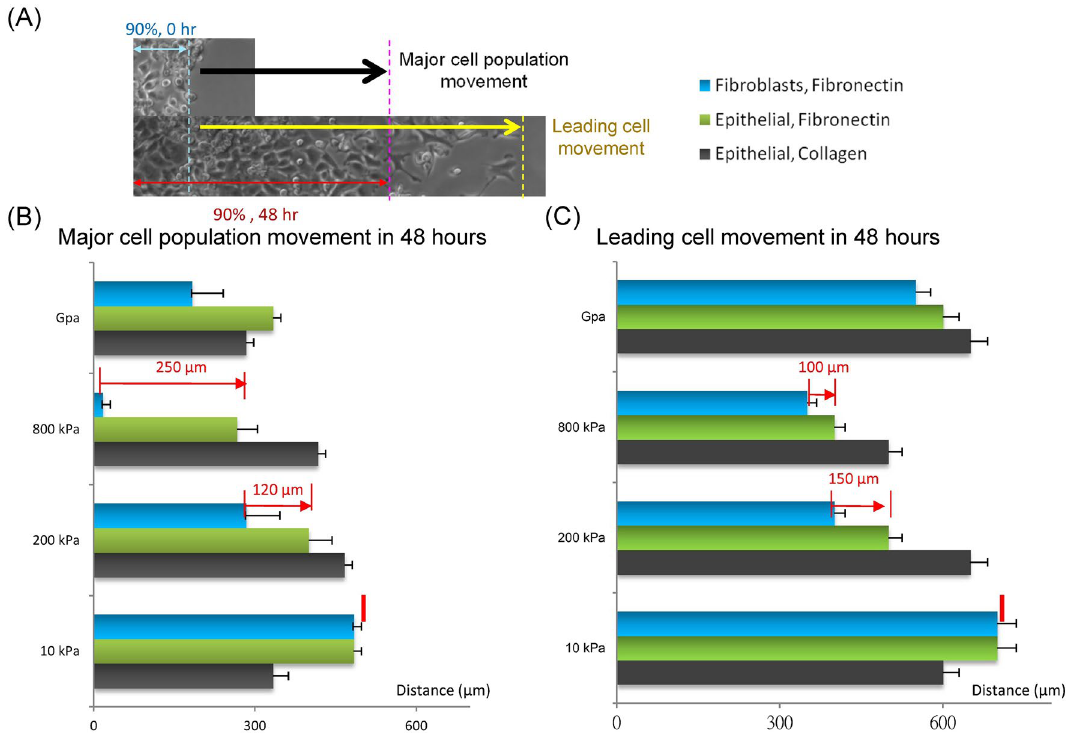
Figure 4. Comparison of cell motility results for A549 epithelial cells and WI-38 fibroblasts on different substrates: ( A ) A diagram to indicate “Major cell population movement” and “leading cell distance”. ( B ) A comparison of cell motility results for the major cell population movement for A549 epithelial cells attached on fibronectin coated PDMS substrates, A549 epithelial cells attached on collagen coated PDMS substrates, and WI-38 fibroblasts attached on fibronectin coated PDMS substrates with stiffnesses including 10 kPa, 200 kPa, 800 kPa and glass. Data are standard deviation. ( C ) A comparison of cell motility results with the leading cell movement for A549 epithelial cells attached on fibronectin coated PDMS substrates, A549 epithelial cells attached on collagen coated PDMS substrates, and WI-38 fibroblasts attached on fibronectin coated PDMS substrates with stiffnesses from 10 kPa, 200 kPa, 800 kPa and glass. The difference in cell response between the two cell types to substrate stiffness is statistically significant (P values < 10 –5 between the epithelial cells and the fibroblasts for both the 90% distribution and the leading cell